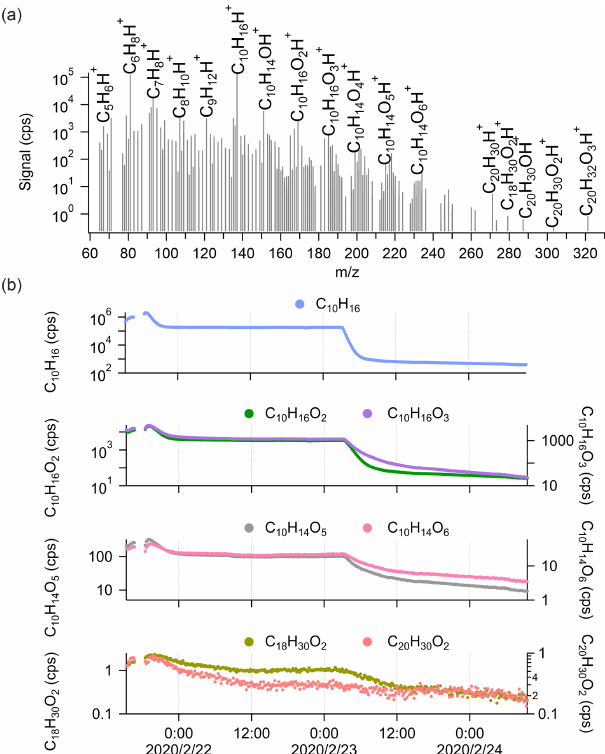
Figure 2. (a) The average mass spectrum of Vocus PTR- TOF measurements during α -pinene (average concentration of 82.4 ± 148.8ppb) ozonolysis in log scale. The peaks of α -pinene, its major fragments inside the Vocus PTR-TOF, and some α - pinene oxidation products are labelled in the spectrum. (b) Time series of α -pinene (C 10 H 16 ) and its oxidation products dur- ing the experiment, including α -pinene monomers (C 10 H 16 O 2 , C 10 H 16 O 3 , C 10 H 14 O 5 , and C 10 H 14 O 6 ) and potential α -pinene dimers (C 18 H 30 O 2 and C 20 H 30 O 2 ). The α -pinene signals were var- ied by changing the